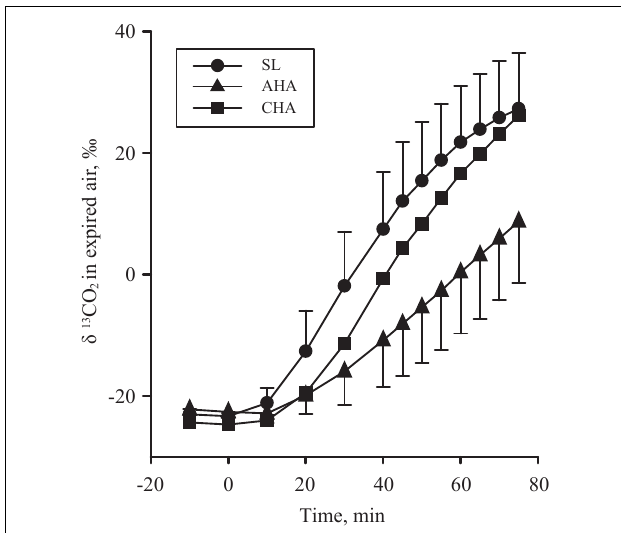
FIGURE 2 | The expired δ 13 CO 2 versus VPDB in participants provided 1.8 g/min carbohydrate (CHO, n = 8, 65.25 g fructose + 79.75 g glucose, closed symbols, during 80-min steady-state exercise (treadmill walking) at sea level (SL) and at 4,300 m altitude, within 5–7 h after arrival (acute high-altitude, AHA) and again on the 22nd day of continuous residence at high-altitude (chronic high-altitude,